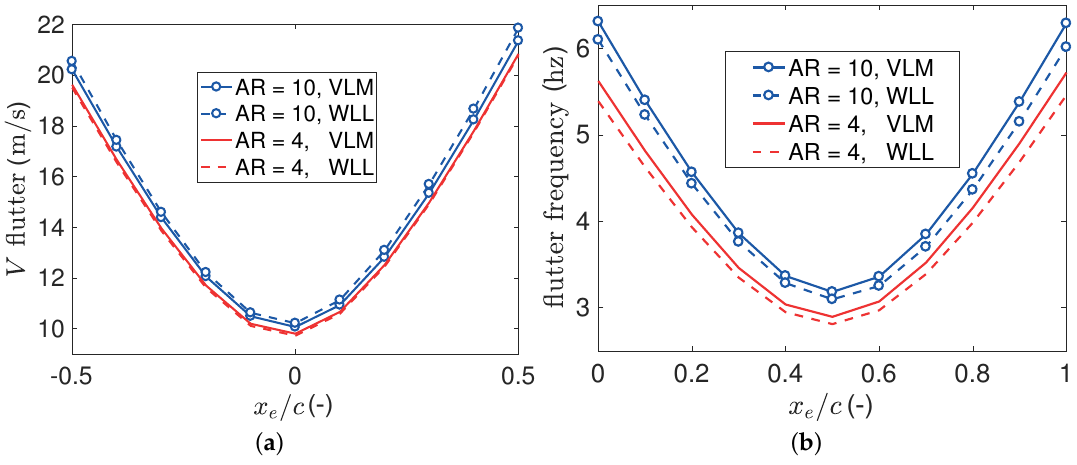
Figure 13. Comparison of flutter with the aeroelastic axis for a 3D wing, computed with vortex lattices (dashed line) and the Wagner lifting line (solid). ( a ) Flutter speed; ( b ) Flutter